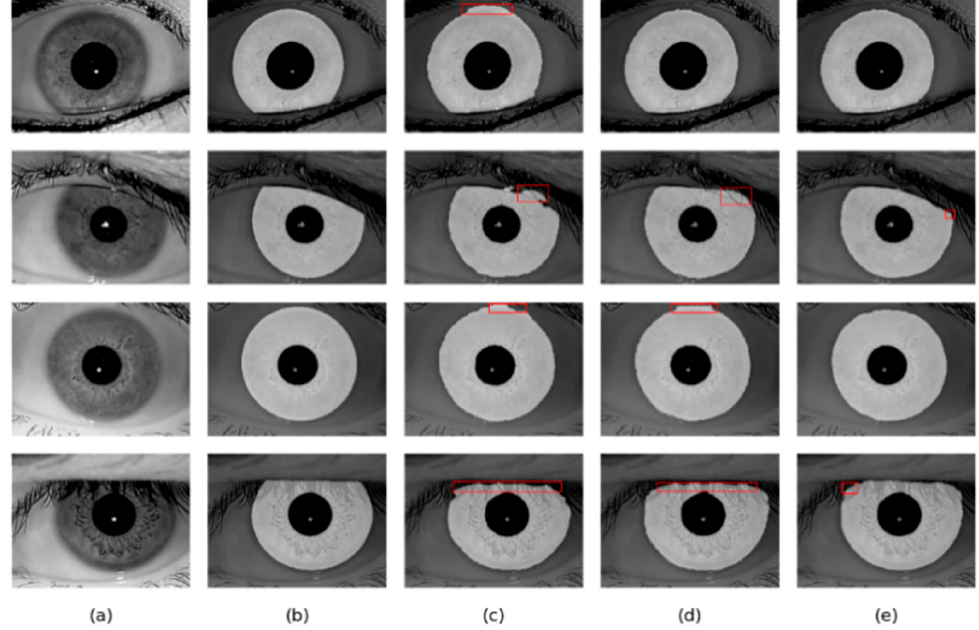
Figure 12. Segmentation results of different methods on the IITD database: ( a ) Original image, ( b ) Ground truth, ( c ) results of Linknet, ( d ) results of DMS-UNet, and ( e ) results of the proposed net- work.